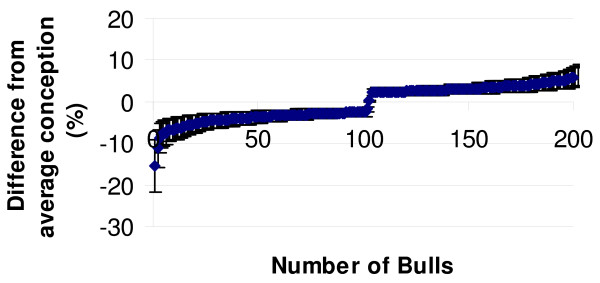
The figure represents the distribution of p-values of the 8,207 markers analyzed in the Phase I study. These p-values were used as guidance to select markers for Phase II.